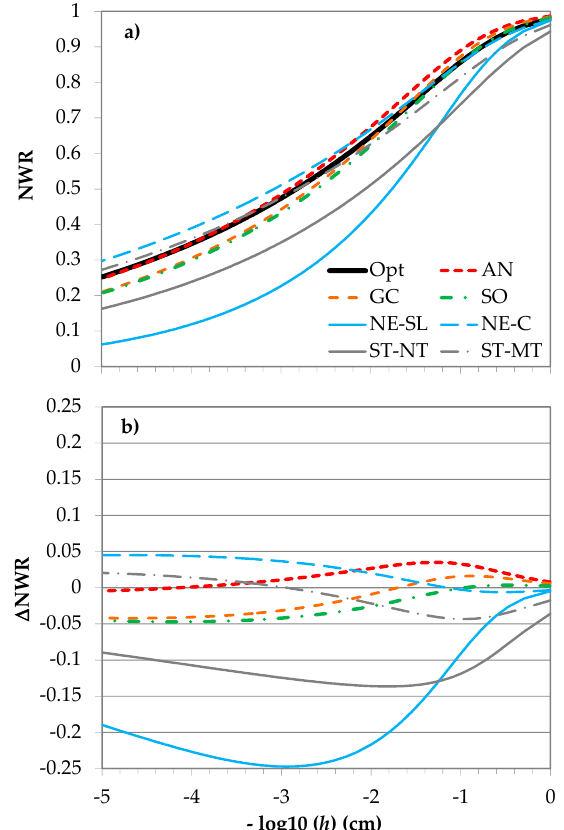
Figure 9. ( a ) Normalized water retention (NWR) of investigated soils plotted with the “optimal” (Opt) curve by Reynolds at al. [35], and ( b ) corresponding differences (estimated–optimal) in normalized water retention values ( Δ NWR) as a function of soil pressure head, h .